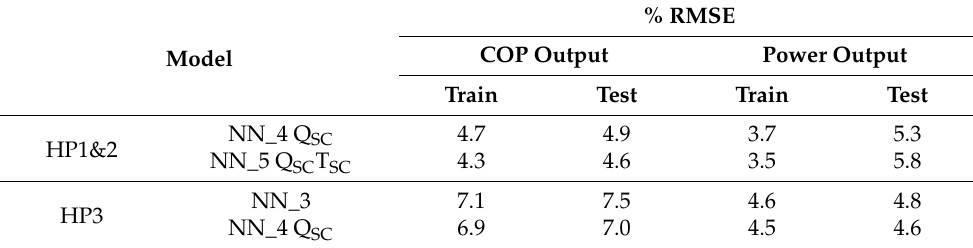
Table 9. Changing the